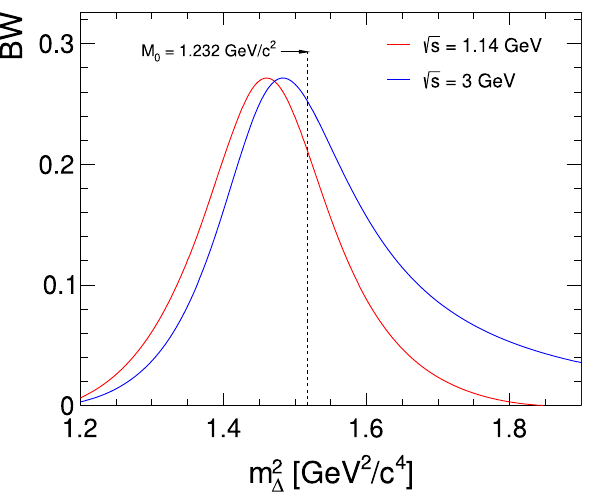
Fig. 160 Relativistic Breit–Wigner mass distributions of the final state Δ ++ in the reaction K + + p → K 0 + π + p at